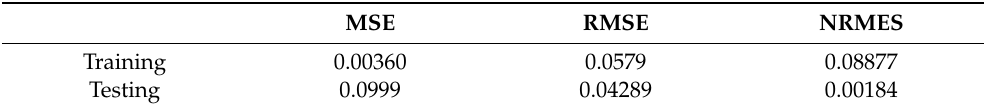
Table 3. Results of the LSTM model for the AMP